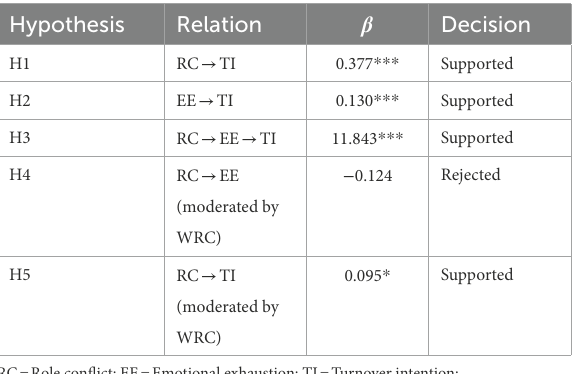
TABLE 6 Hypothesis construct